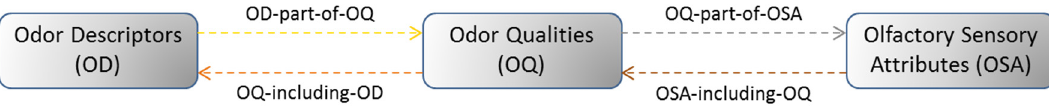
Figure 1. Object properties between the classes OD, OQ, and OSA of the OOPS ontology.